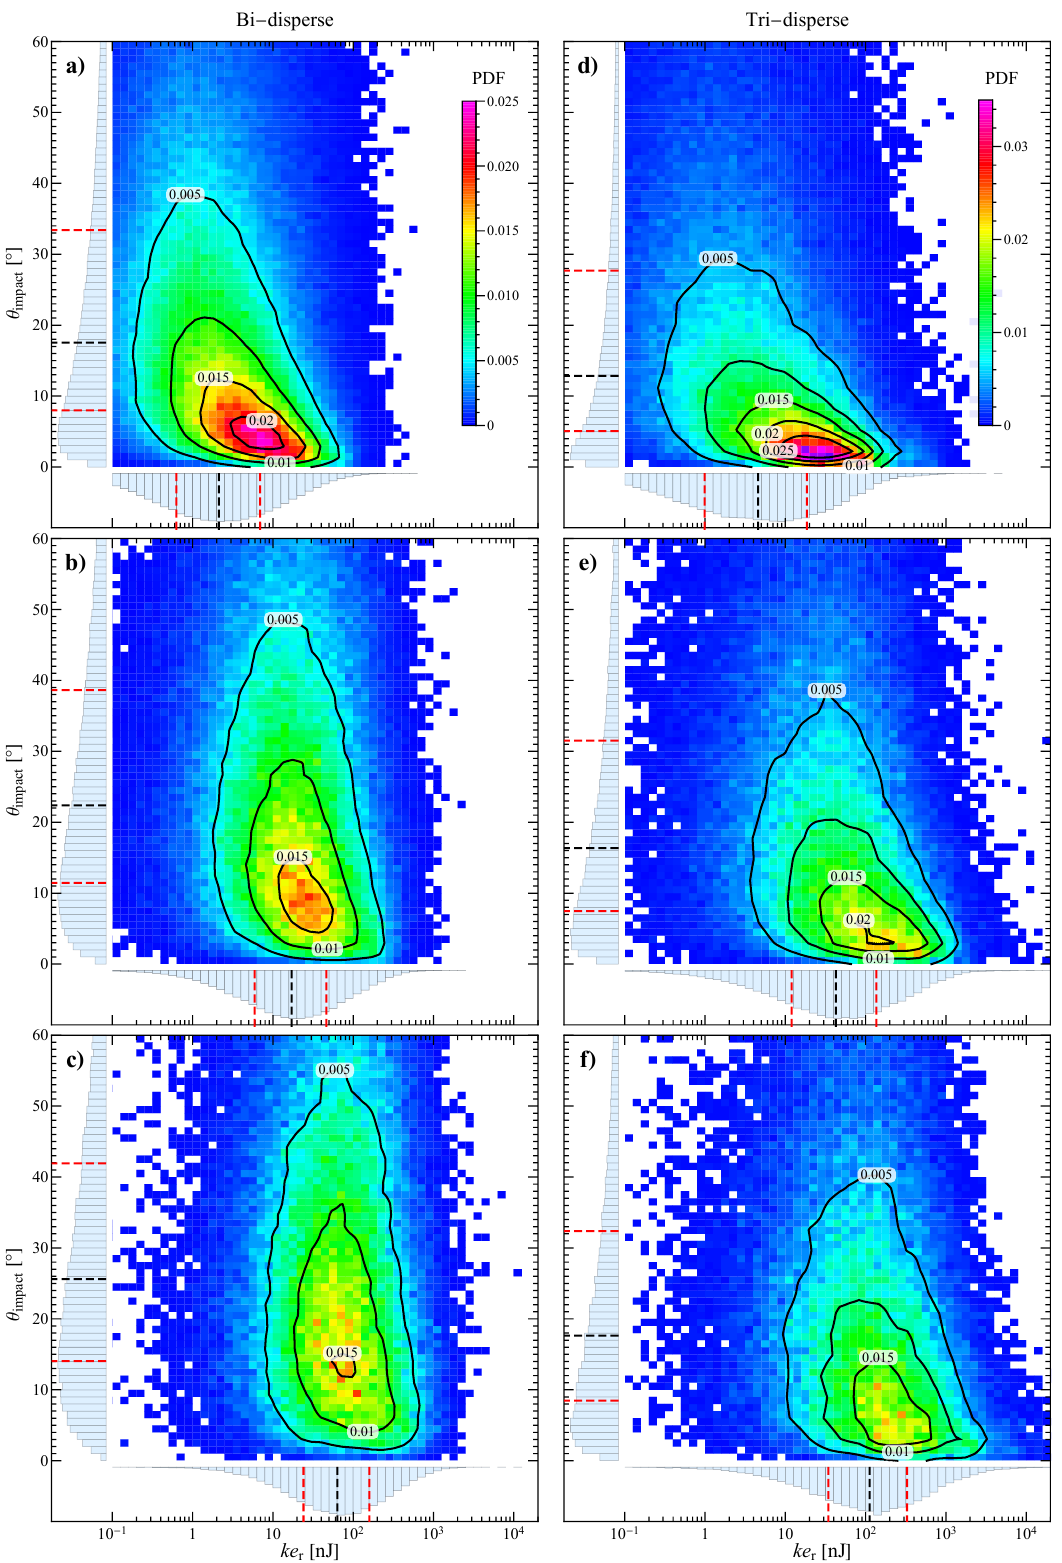
Figure 7. Map and contours of the joint probability density function for impact angle and relative kinetic energy at ( a , d ) 300 rpm, ( b , e ) 600 rpm, and ( c , f ) 900 rpm for the impacts between all the particles in the bi-disperse (left column) and tri-disperse system (right column). On the edges of every map the marginal probability density functions and the corresponding quartiles are also shown (the dashed red lines representing the first and third quartiles and the dashed black line the